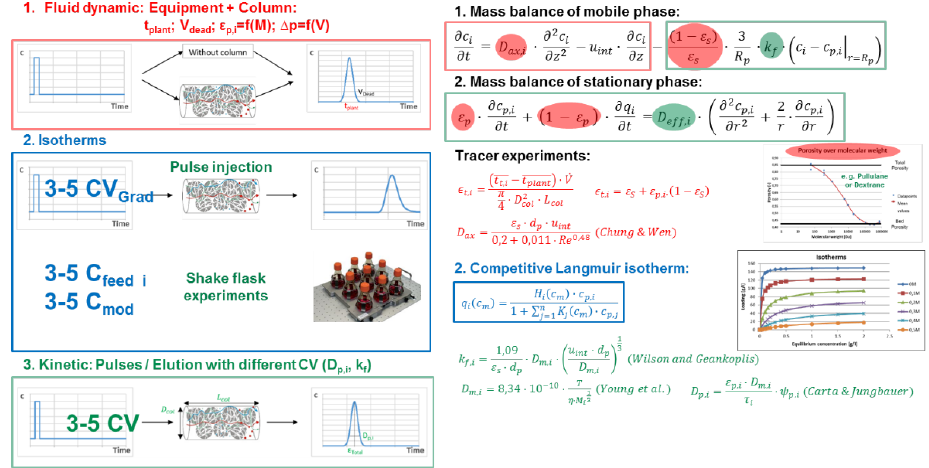
Figure 10. Chromatography process modeling workflow, recipe, SOP.